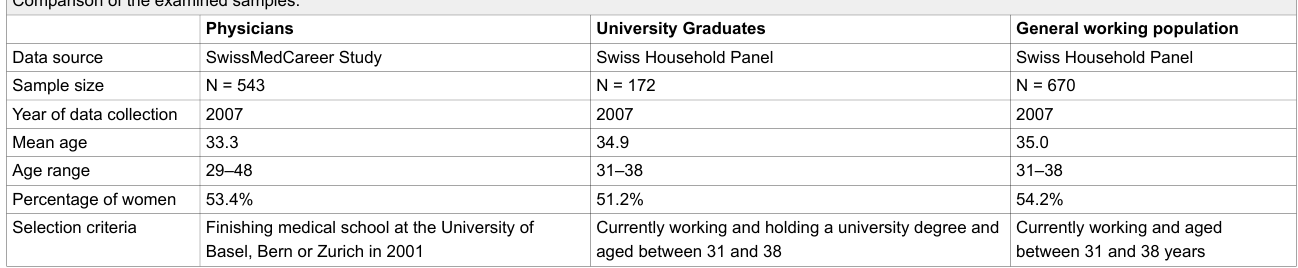
Table 1 Comparison of the examined